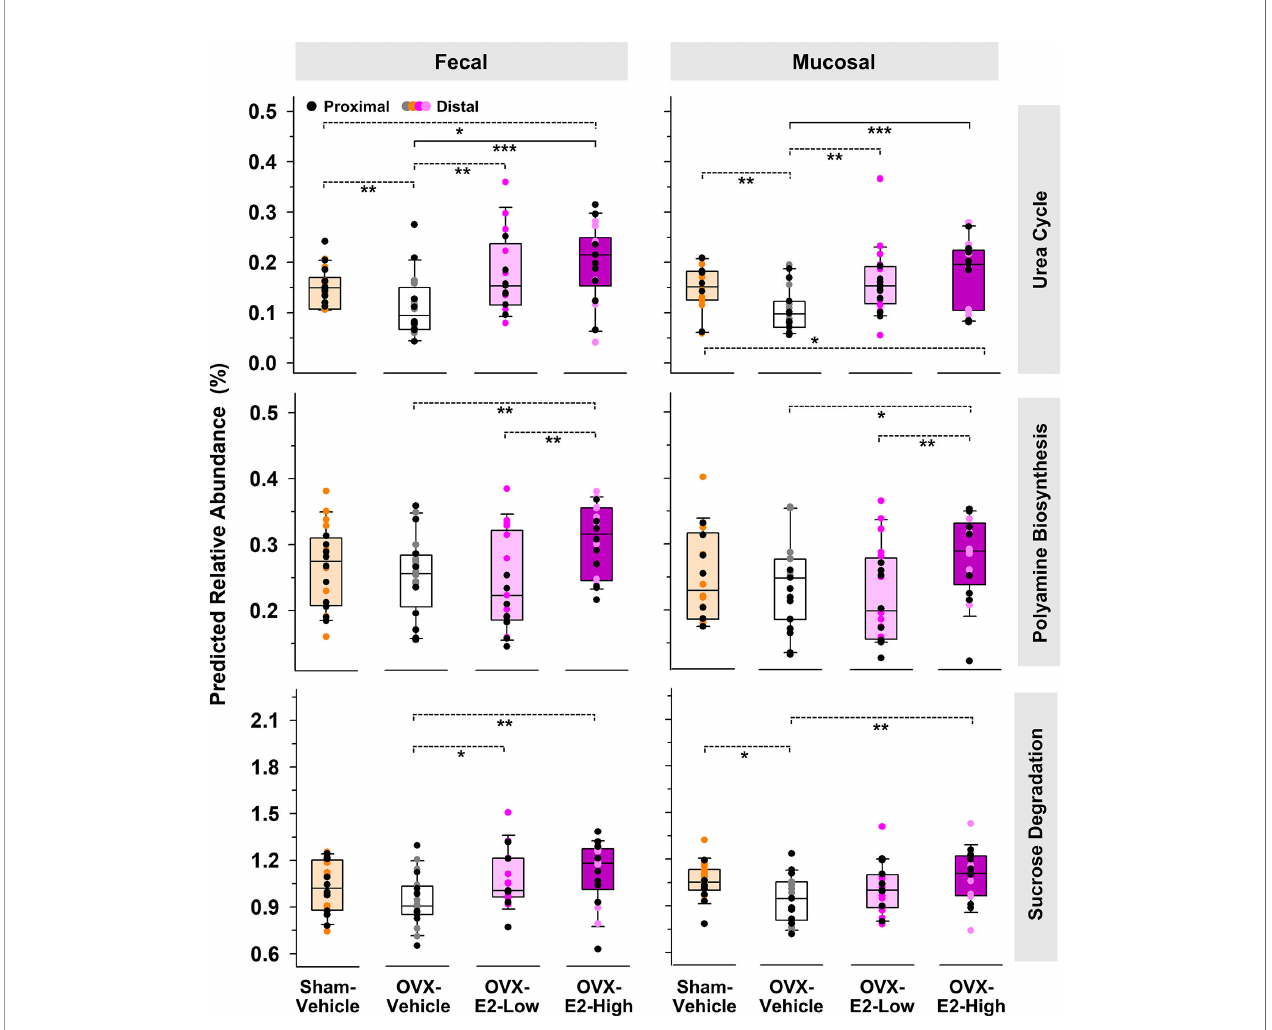
FIGURE 3 | Predicted pathways (based on 16S rRNA gene sequences) that displayed a signi fi cantly (LEfSe) higher relative abundances in OVX-E2-High rats than in OVX-Vehicle rats. Relative abundance of polyamine biosynthesis and sucrose degradation represents the sum of the predicted relative abundance of arginine and polyamine biosynthesis and polyamine biosynthesis I and sucrose degradation III and IV, respectively ( Supplemental Figure S9 ). Urea cycle: PWY-4984. The asterisks indicate signi fi cant differences (*p ≤ 0.05; **p ≤ 0.01; ***p ≤ 0.001). Solid lines between groups indicate signi fi cant q values (q ≤ 0.05). Dashed lines between groups indicate non-signi fi cant q values. Group abbreviations (e.g., Sham-Vehicle) are described in Table 1 . Error bars indicate standard